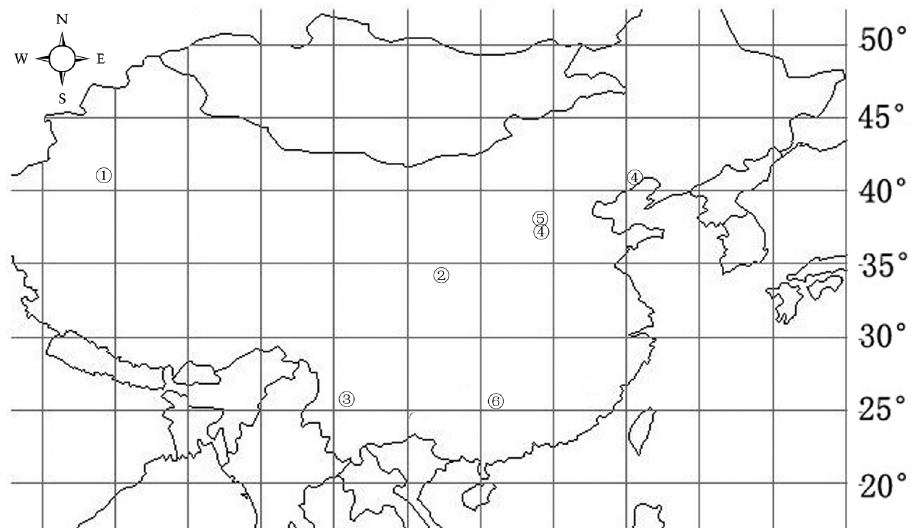
Figure 13. Records of Zodarion species in China. ① Zodarion apertum sp. n. ② Zodarion planum sp. n. ③ Zodarion ovatum sp. n. ④ Zodarion chaoyangense Zhu & Zhu, 1983 ⑤ Zodarion furcum Zhu, 1988 ⑥ Zodarion hunanense Yin,